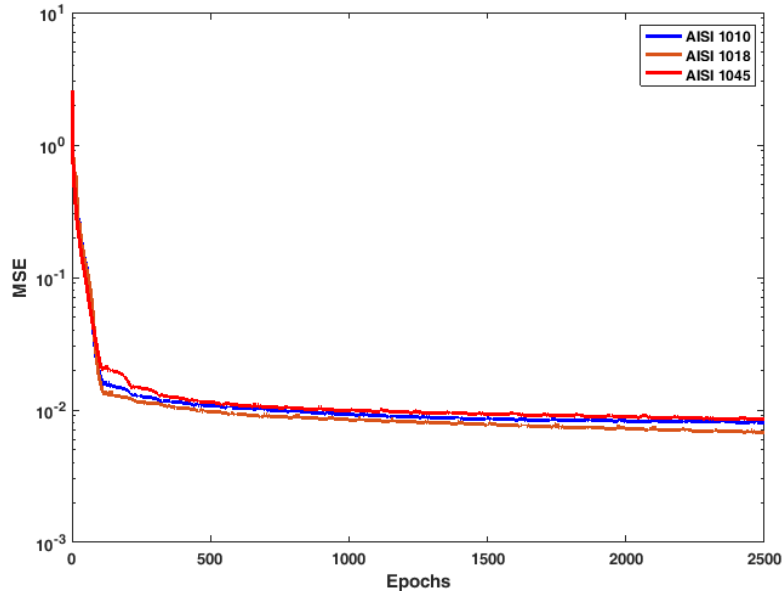
Figure 4. Variation between MSE and the number of epochs of ANN training for AISI 1010, 1018, and 1045 steel. Table 4. Mean square error (MSE) for different AISI grades steel.